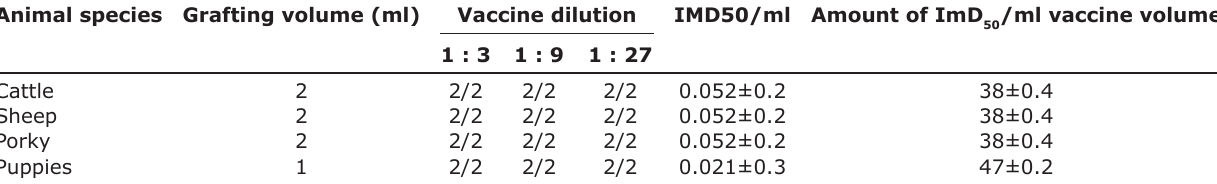
Table-2: Determination of 50% of the immunizing dose of an inactivated vaccine against Aujeszky’s disease for various animal species. Animal species Grafting volume